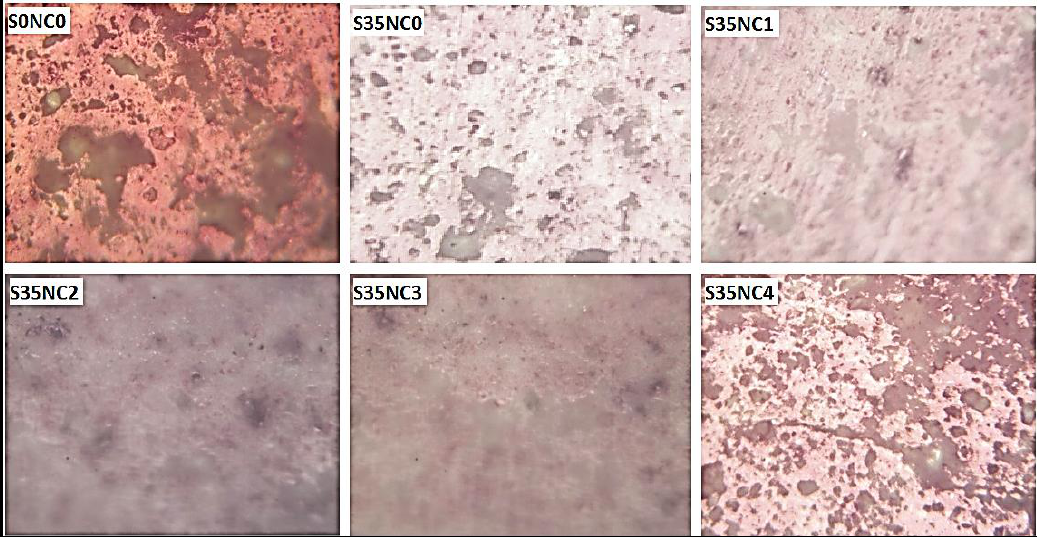
Figure 6. The mass loss after exposing the dried samples to 300 °C for 3 days.